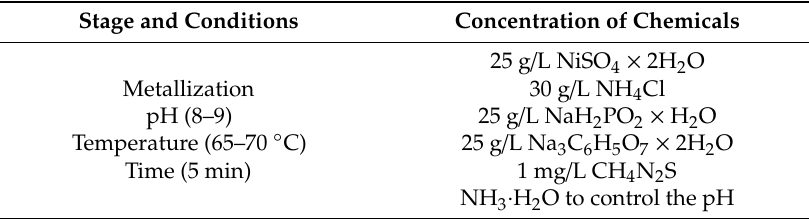
Table 3. The Solution Composition and Experimental Conditions of Electroless Nickel Plating.